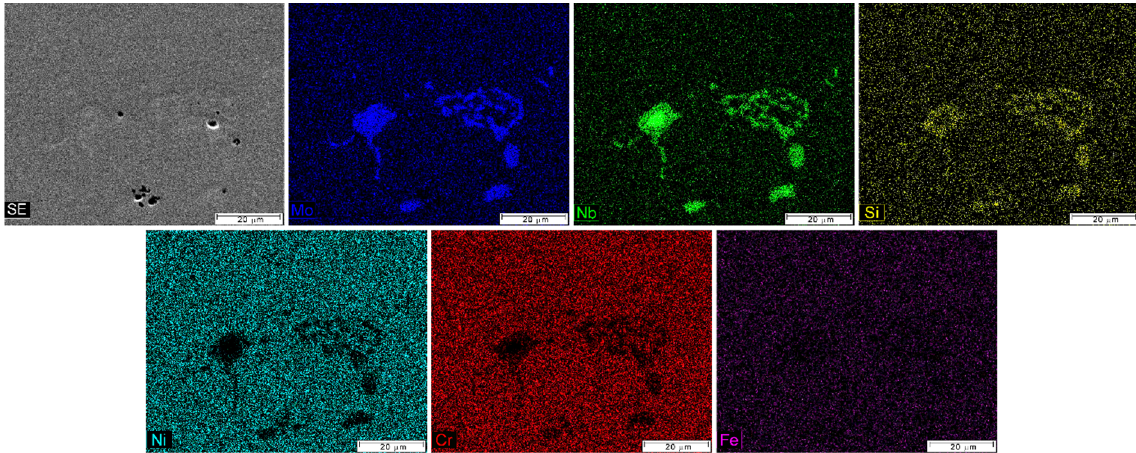
Figure 6. EDS chemical distribution mapping of Mo, Nb, Si, Ni, Cr and Fe elements in intermetallic particles present in Figure 4b.